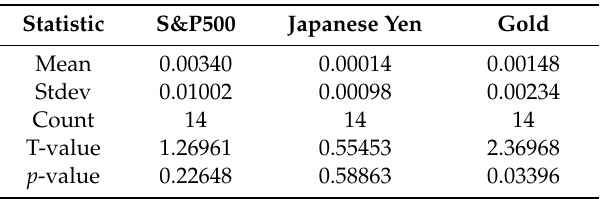
Table A11. The ($)h c-BA ’s HE − the ($) h T ’s